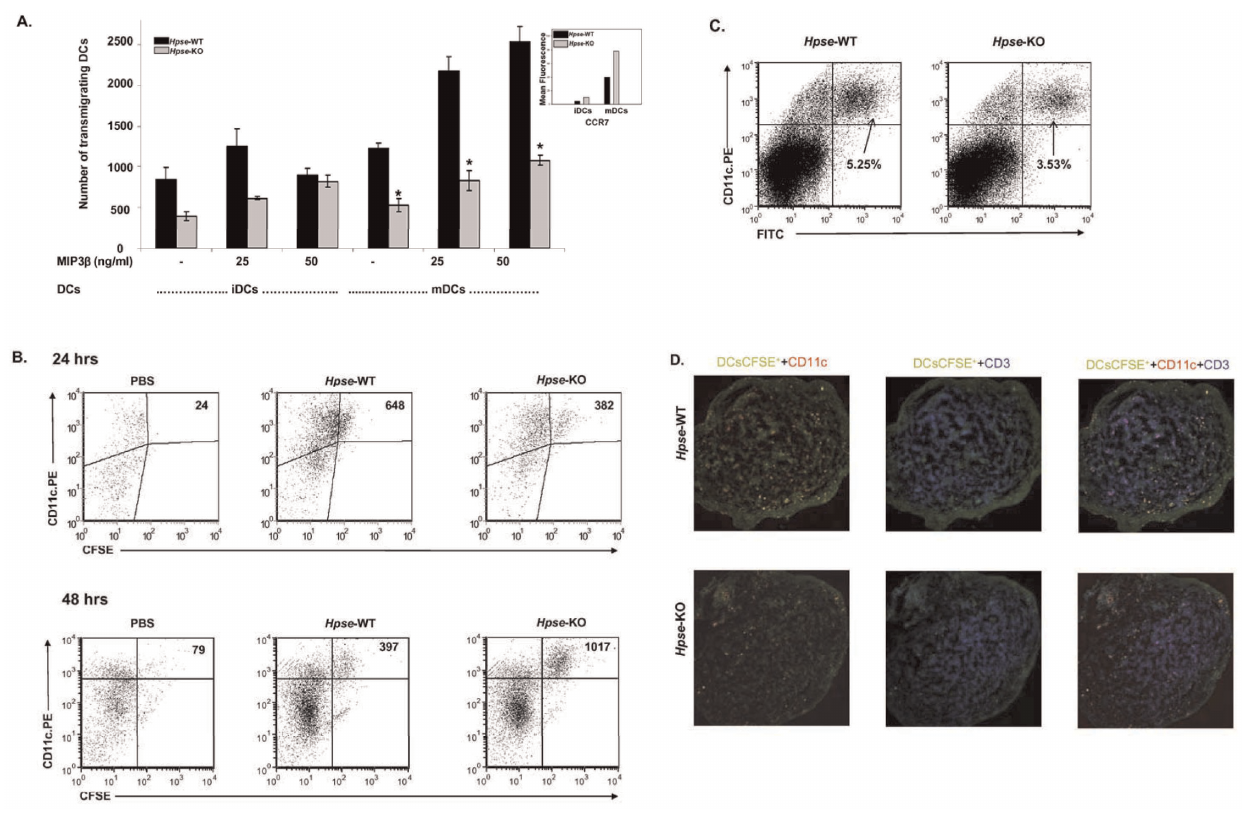
Figure 5. Heparanase is needed for in vitro and in vivo transmigration. A . In vitro transmigration of iBMDCs or mBMDCs from Hpse- WT (black bars) and Hpse -KO mice (gray bars). Cells were incubated in transwells coated with Matrigel (15 m g/50 m l DDW) 20–24 h at 37 u C. Cells were incubated with the lower chamber medium containing RPMI, RPMI with 25 ng/ml MIP3 b or RPMI with 50 ng/ml MIP3 b . Representative of three experiments. Asterisk indicates p , 0.02, t-test. B. In vivo DC transmigration. Flow cytometry. Dot plot of CD11c + and CFSE + cells from a popliteal lymph node following foot pad injection of PBS, or, 2 6 10 6 mBMDCs from Hpse- WT, or 2 6 10 6 mBMDCs from Hpse -KO mice. mBMDCs were stained with CFSE and injected SQ into the footpads of Hpse- WT mice. 24 hours or 48 hours after injection, the regional popliteal lymph node was extracted and analyzed for the presence of CFSE + cells by flow cytometry. CyoCount beads were used to evaluate cells that had migrated to the popliteal lymph nodes. Representative of three experiments, (p , 0.001). C. In vivo FITC skin painting. Dot plot of double positive CD11c-PE + and FITC + cells from inguinal lymph nodes. The shaved abdomen was painted with FITC solution. 24 hours after the skin painting, the inguinal lymph node was extracted and analyzed for the presence of CFSE + cells by flow cytometry. D. Indirect immunofluorescence of frozen sections. Regional popliteal lymph node frozen section of the same experiment in C . Confocal microscopy of lymph nodes stained as described in Methods. CFSE-migrating DCs (green), CD11c migrating (yellow merged), local DCs (red), and T cells (blue), are seen.